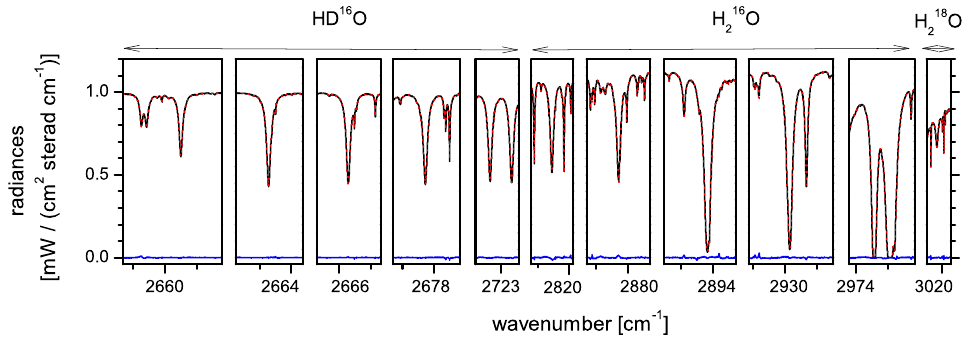
Fig. 2. Spectral microwindows used for the ground-based FTIR MUSICA retrievals. Shown is an example for a typical measurement at Iza˜na (26 October 2011, 11:02UT; solar elevation: 41.7 ◦ ; H 2 O slant column: 6.3mm; DOFS for H 2 O: 2.95). Black line: measurement; red dashed line: simulation; blue line: residual (difference between measurement and simulation).